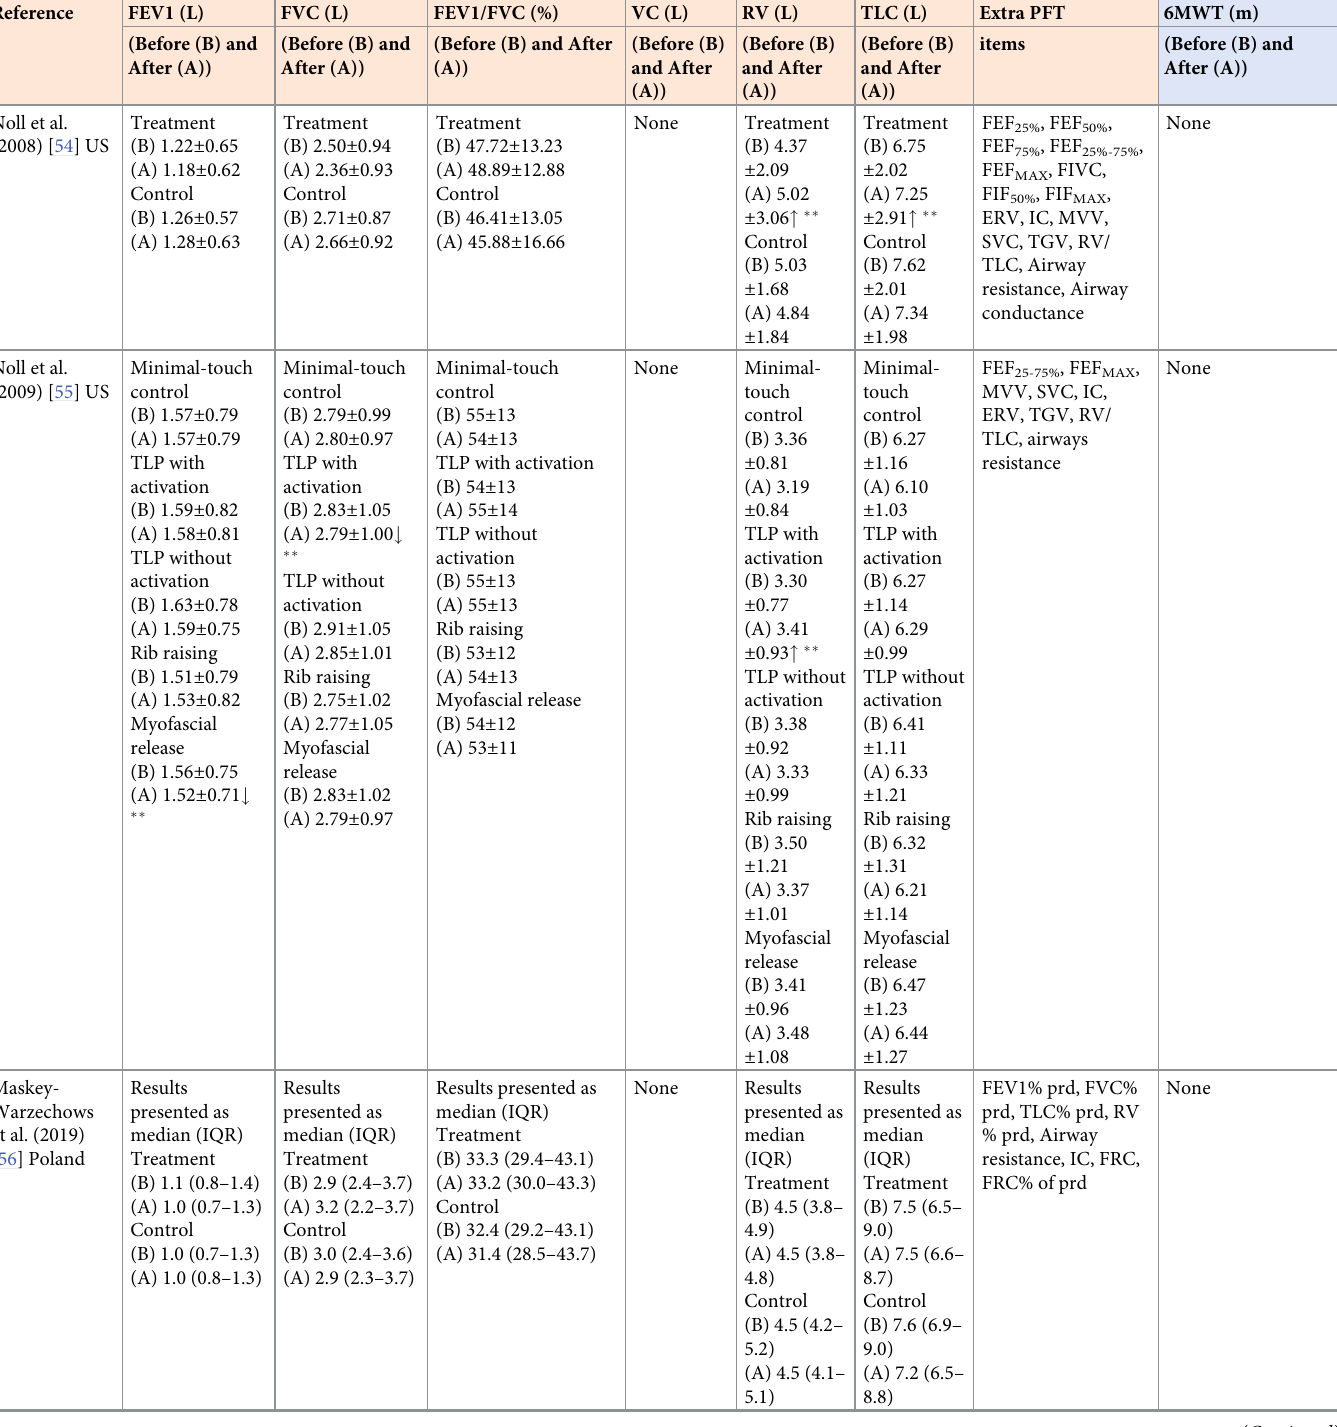
Table 2. Summary of primary outcomes.